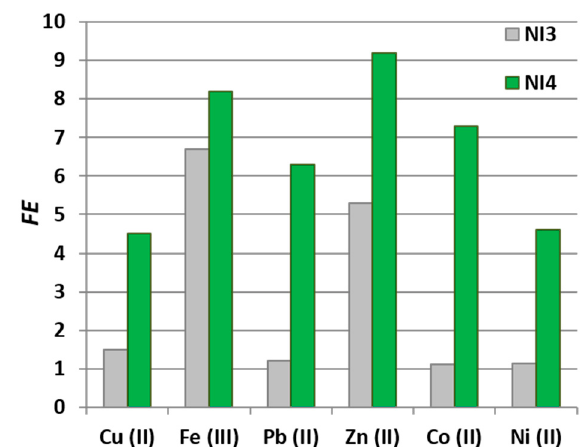
Figure 10. The fluorescence enhancement factor ( FE ) of NI3 and NI4 (c = 1 × 10 − 5 mol L − 1 ) in the presence of metal cations (c = 1 × 10 − 5 mol L − 1 ) in an acetonitrile solution.